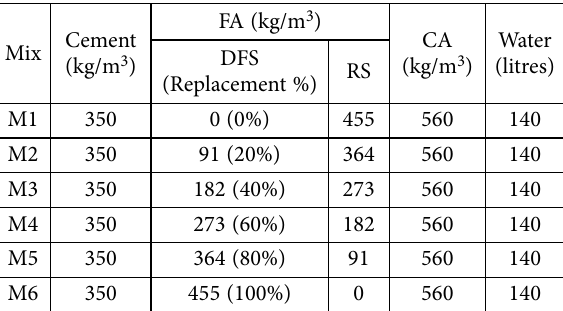
Table 3. Mix proportion of trial